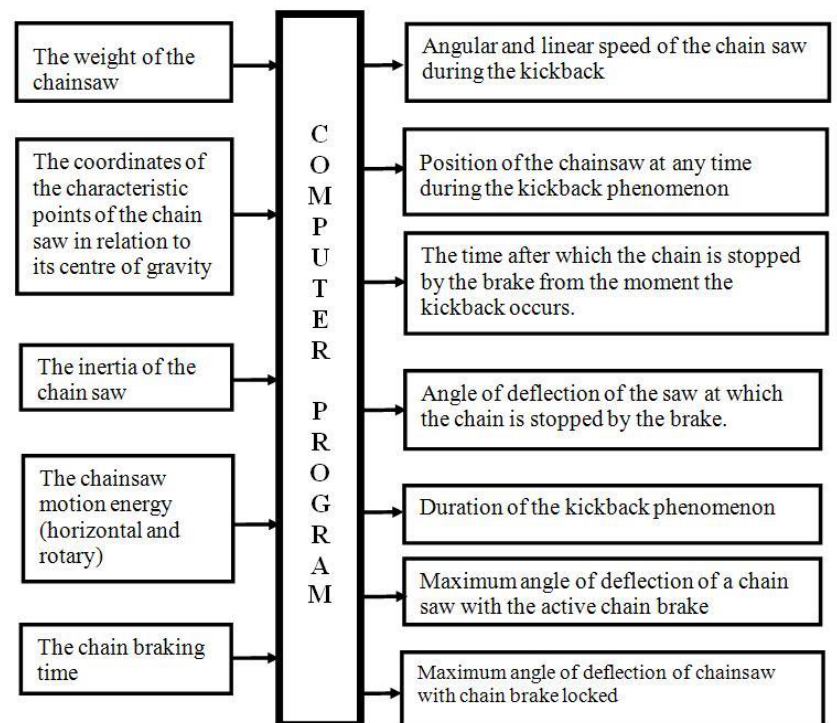
Figure 2. Scheme for carrying out chainsaw kickback tests.